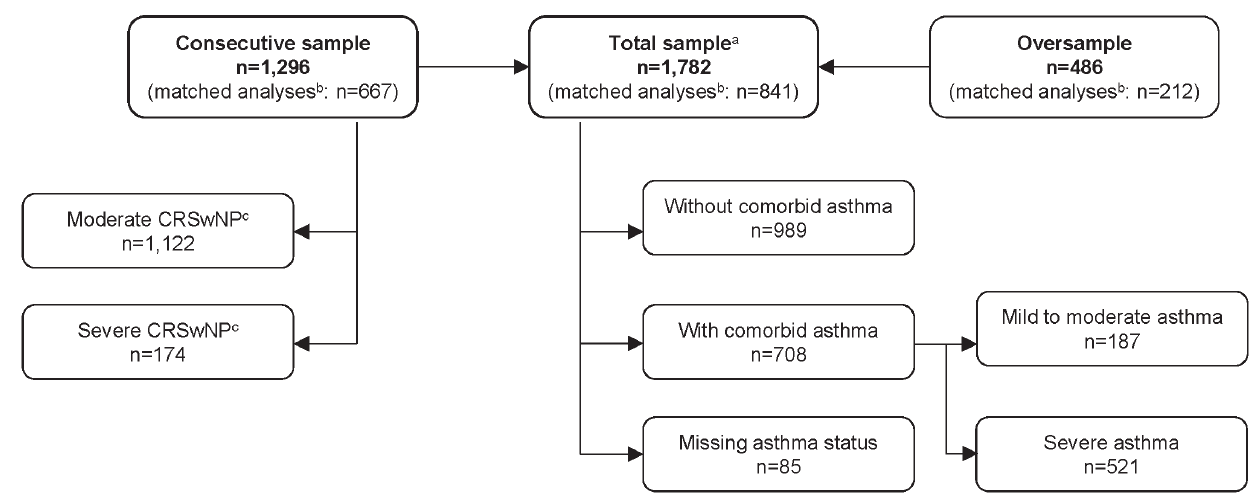
Figure 1. Flowchart of patient sampling and populations